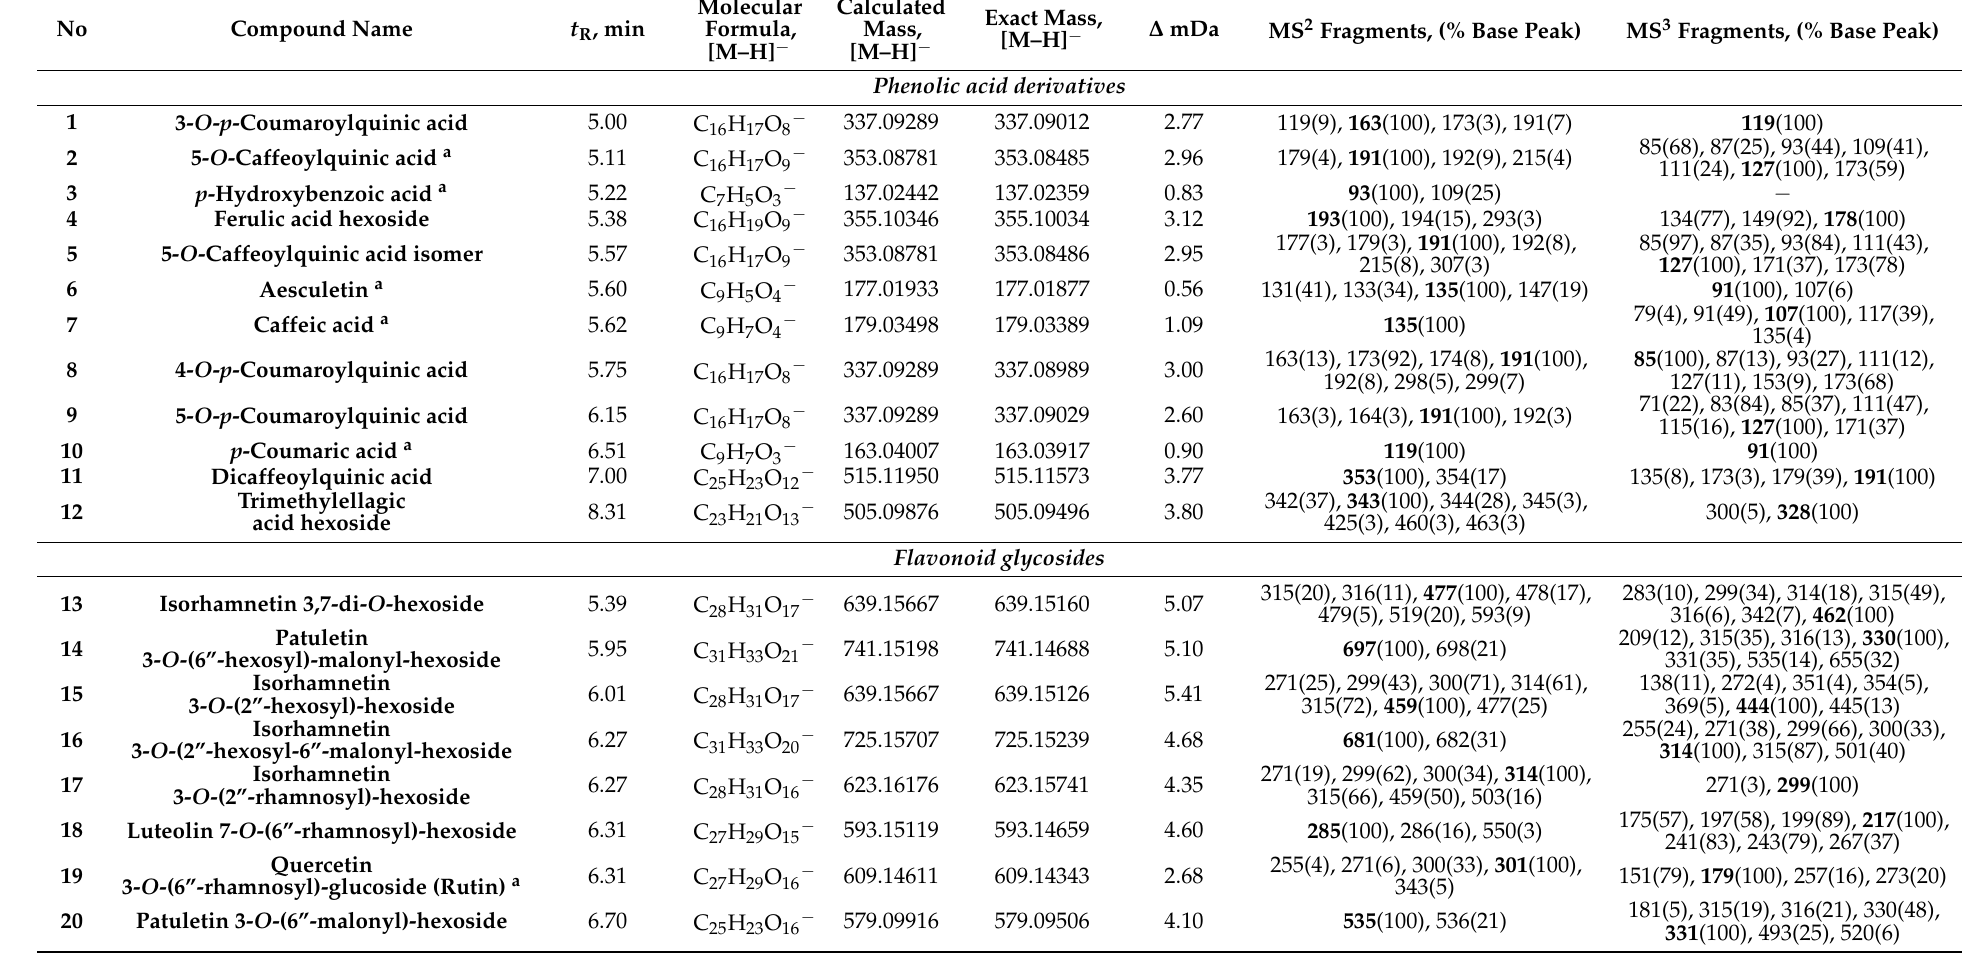
Table 3. High resolution and negative ion MS3 data about identified polyphenolics in pear nectar